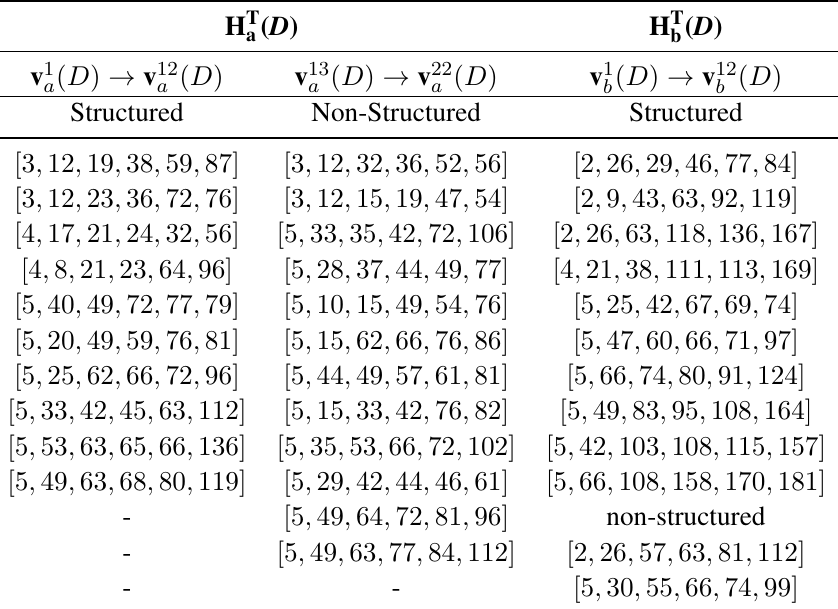
( D ) | l = 1 , 2 , . . . , 10 } are the base structured ( D ) | k = 1 , 2 , . . . , 10 } and { v l Table 3 the codewords { v k a b codewords, and the rest are the non-structured ones. Table 3. Minimum weight codewords of the super